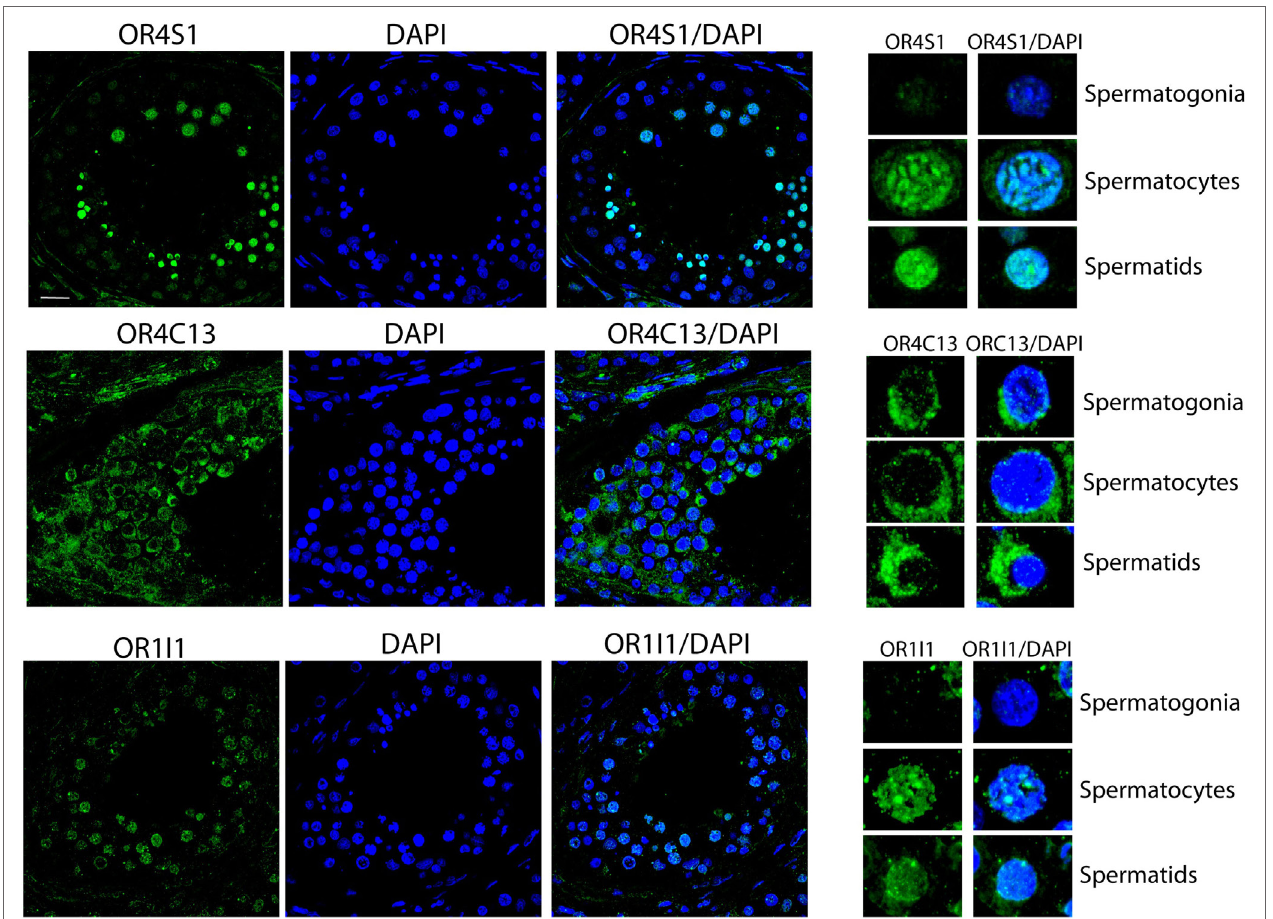
FigUre 3 | Confocal analysis of OR4S1, OR4C13, and OR1I1 protein expression in testicular tissue. Nuclei were counterstained with DAPI (scale bar 25 µm). Representative panels showing spermatogonia, spermatocytes, and spermatids at high magnification are included in the